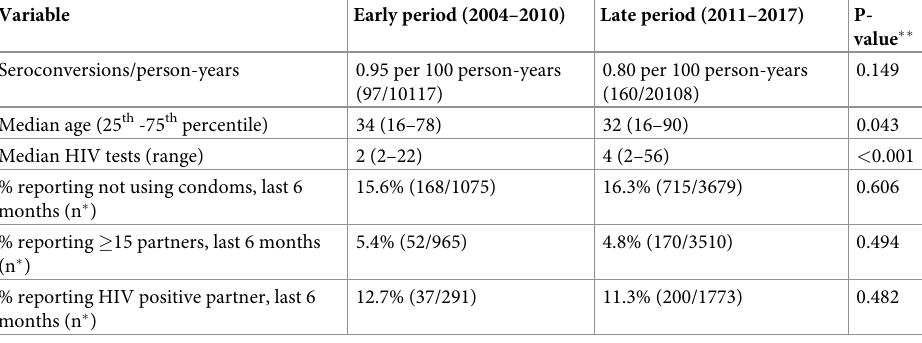
Table 2. Descriptive statistics comparing the early (2004 to 2010) and late (2011 to 2017) halves of the study period. Variable